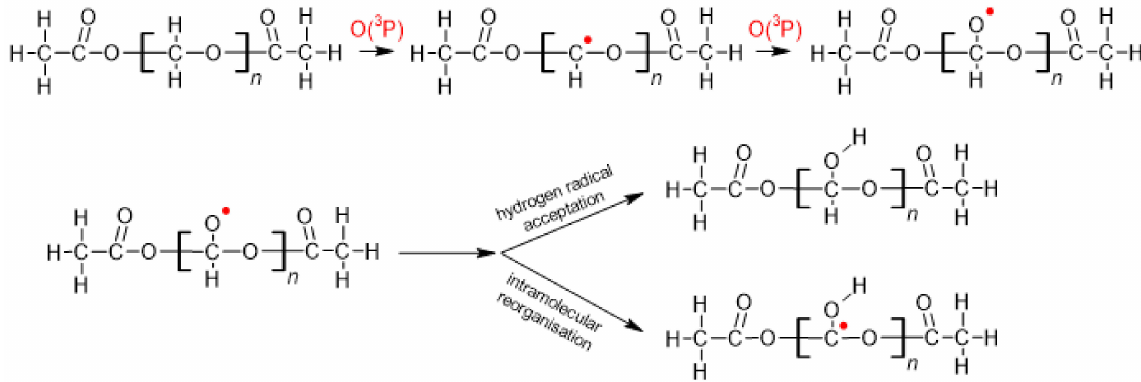
Figure 5. Exemplary diagram of the POM surface oxidation as a result of oxygen plasma modification.